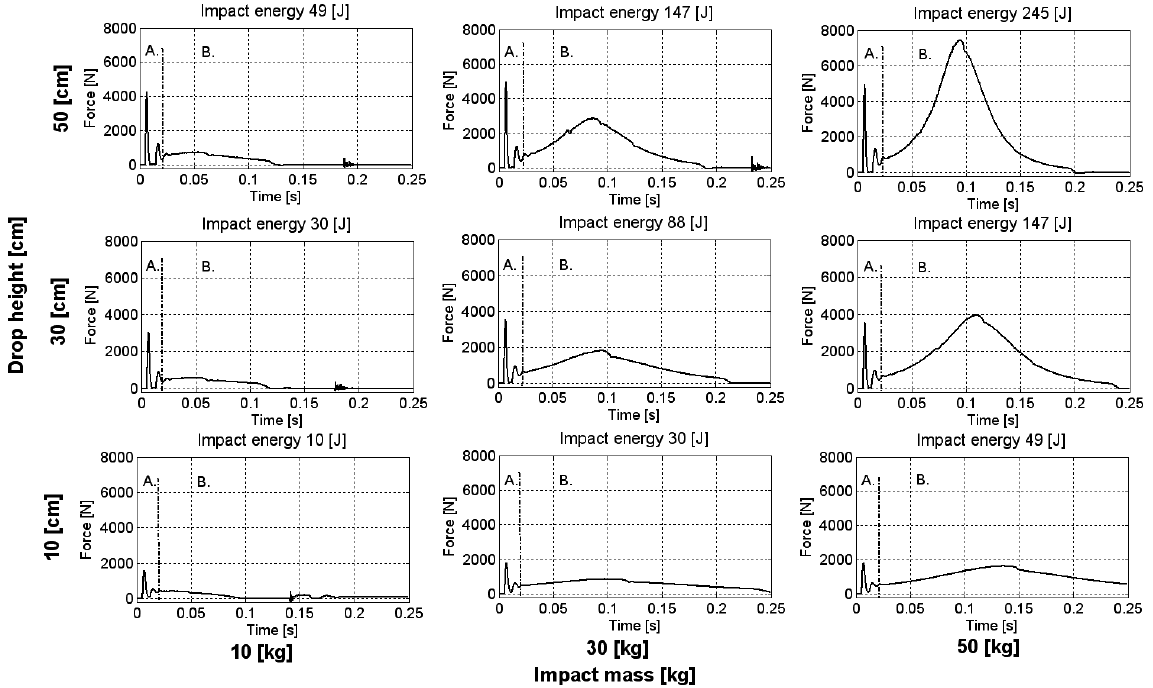
Fig. 3. The effect of impact mass and velocity on the contact force time-history for initial pressure 100 kPa. lower chamber which remains closed the term denoting enthalpy vanishes and differential Eq. (9) simpli fi es to